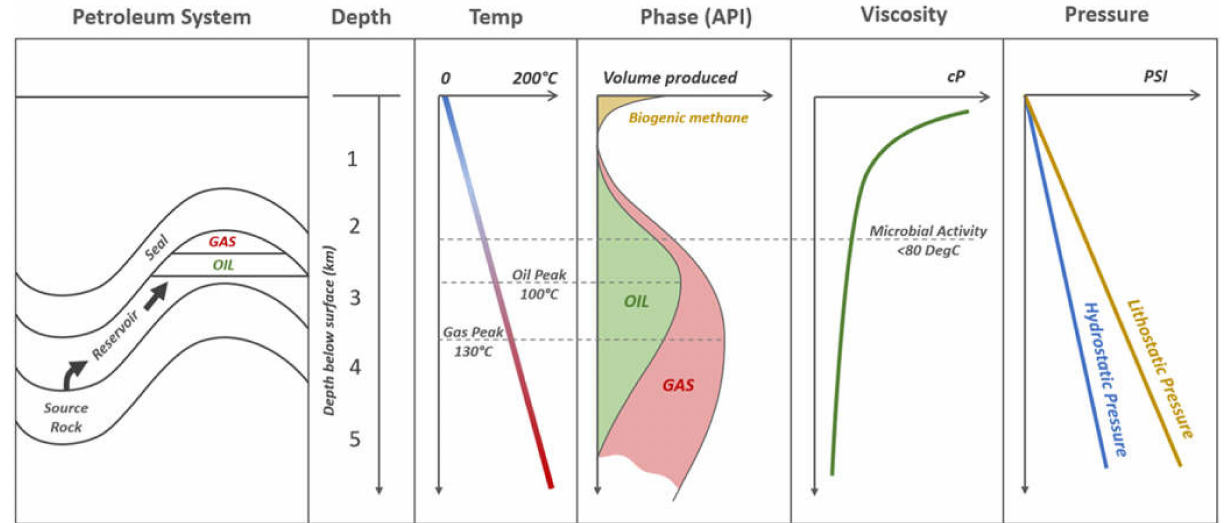
Figure 19. The approximate relationship between depth, temperature, API, viscosity and pressure and how these relate to the reservoir fluids. Adapted from